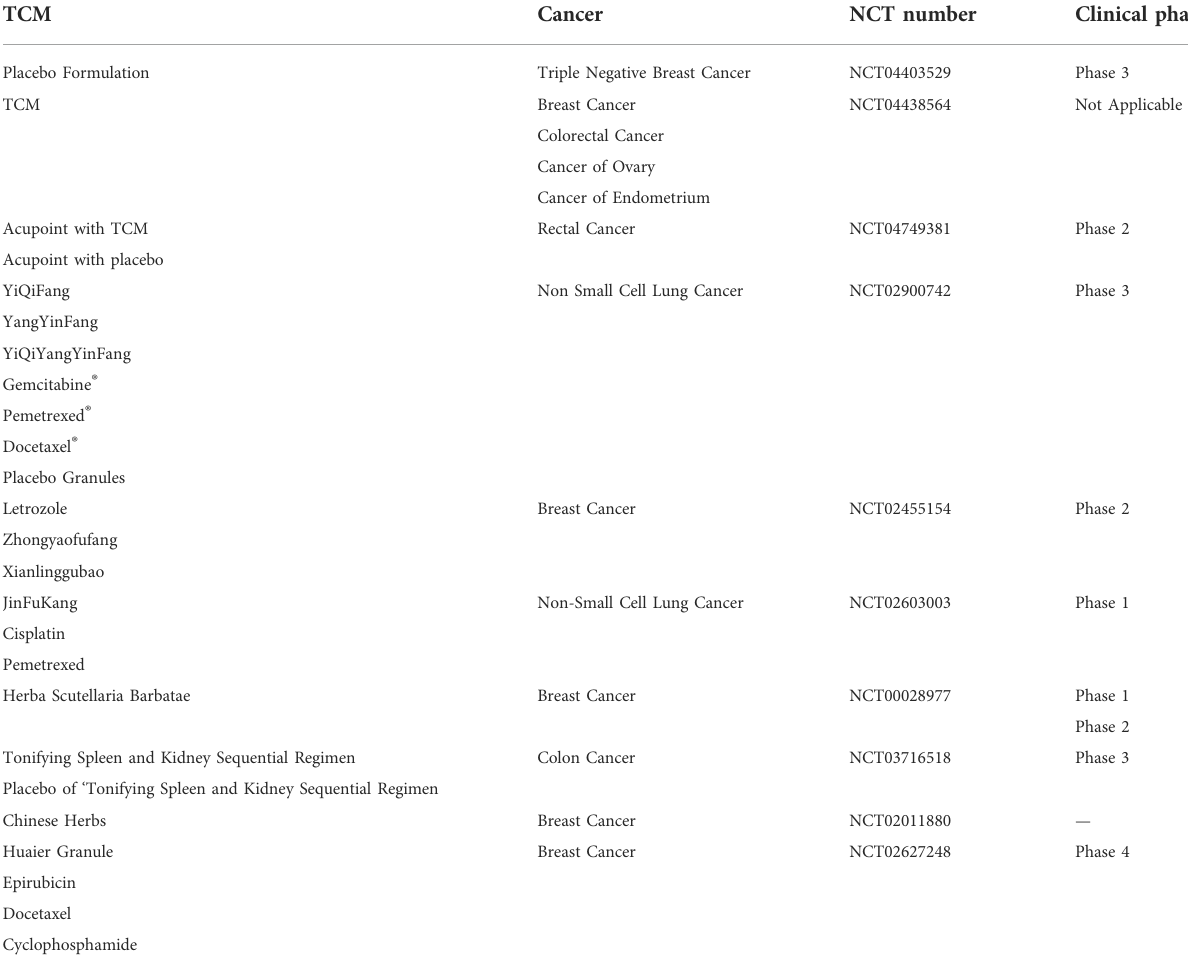
TABLE 2 The current clinical trials of TCM in cancer treatment. The date are obtained from